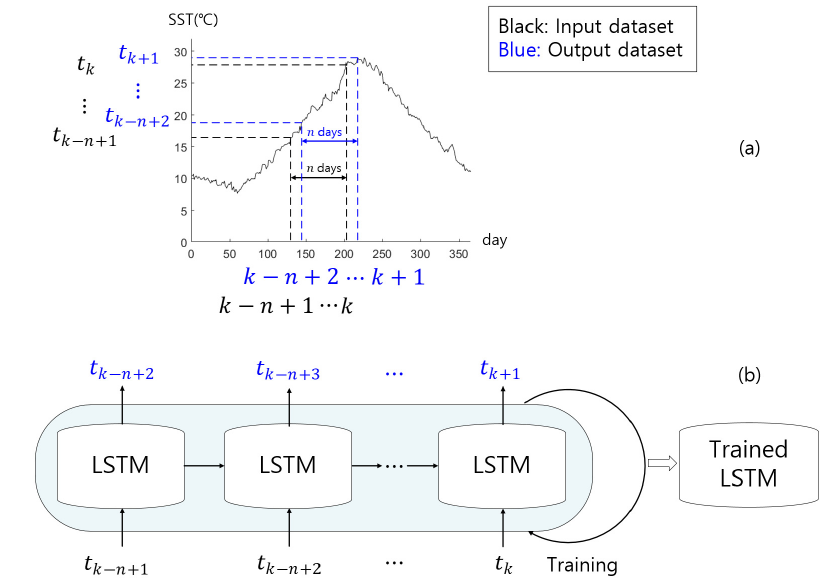
Figure 5. Conceptual model of LSTM training for SST prediction. ( a ) A typical 1-year SST data series. ( b ) A schematic diagram of LSTM model training to predict SST.